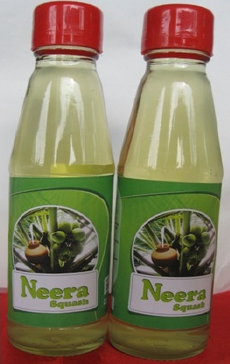
Figure 6. Coconut Neera concentrate (squash) developed from processed Neera.